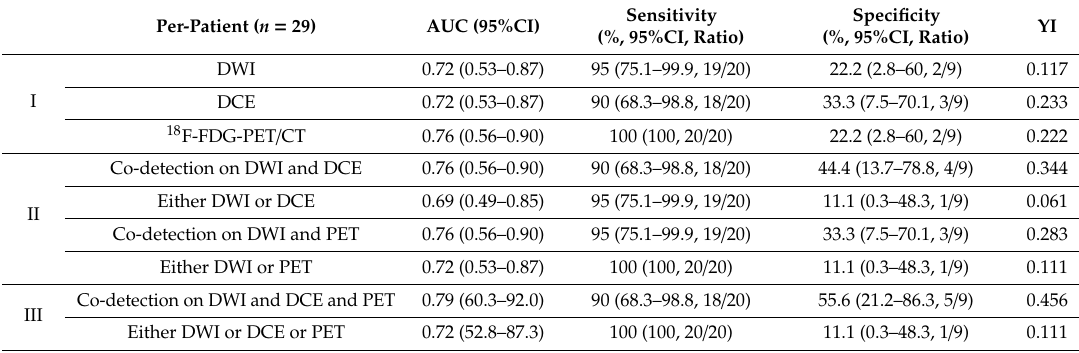
Table 4. The per-patient diagnostic accuracy of I) single use of DWI, DCE or 18 F-FDG-PET / CT. II) The combined use of DWI + DCE and separately PET + DWI; of which the first line comprised a co-detection on both imaging modalities rated positively for malignancy. The second line comprised an independent detection on DWI or DCE and separately PET + DWI, in which either one was rated positively. III) The combination of DWI + DCE + PET; in which the first line comprised a co-detection on all DWI + DCE + PET rated positively for malignancy. The second line comprised an independent detection on DWI, DCE or PET, in which either one was rated